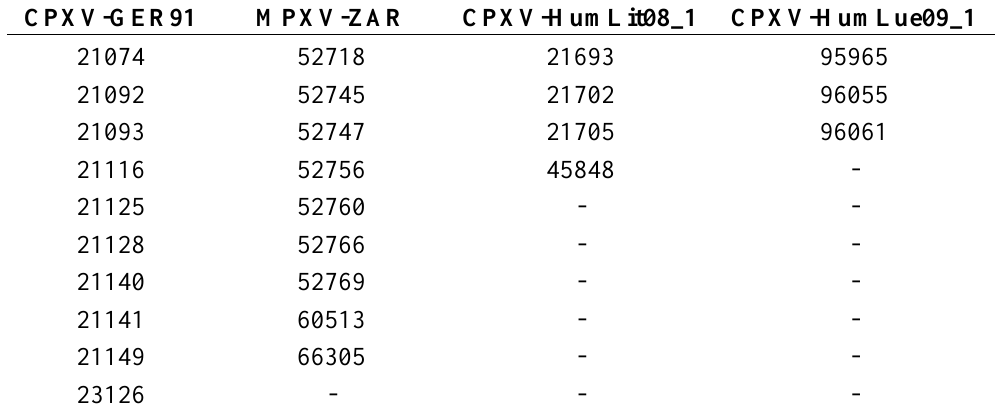
Table 4. Positions where all four viruses of the variola virus (VARV) clade are the same and all others are different, except the single virus shown.